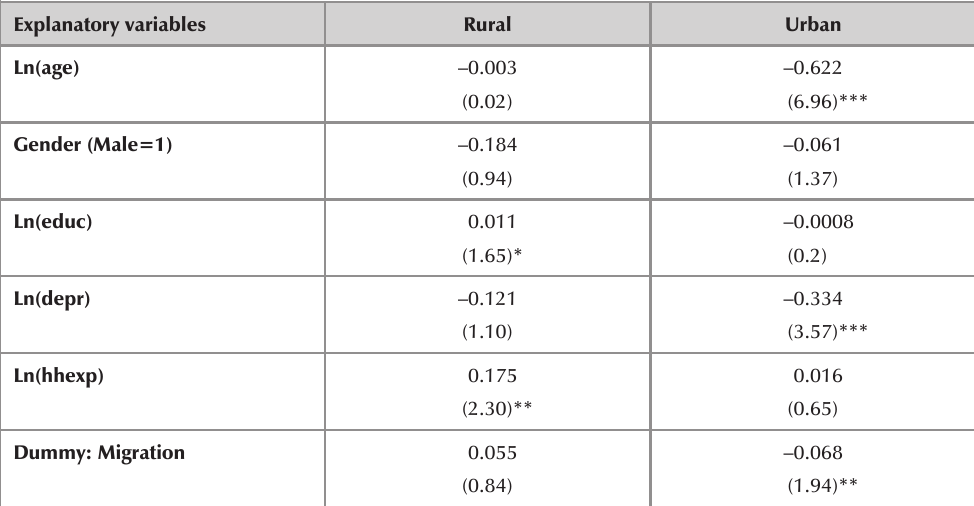
Heckman probit model with sample selection for credit rationing in credit markets (rural/urban) in